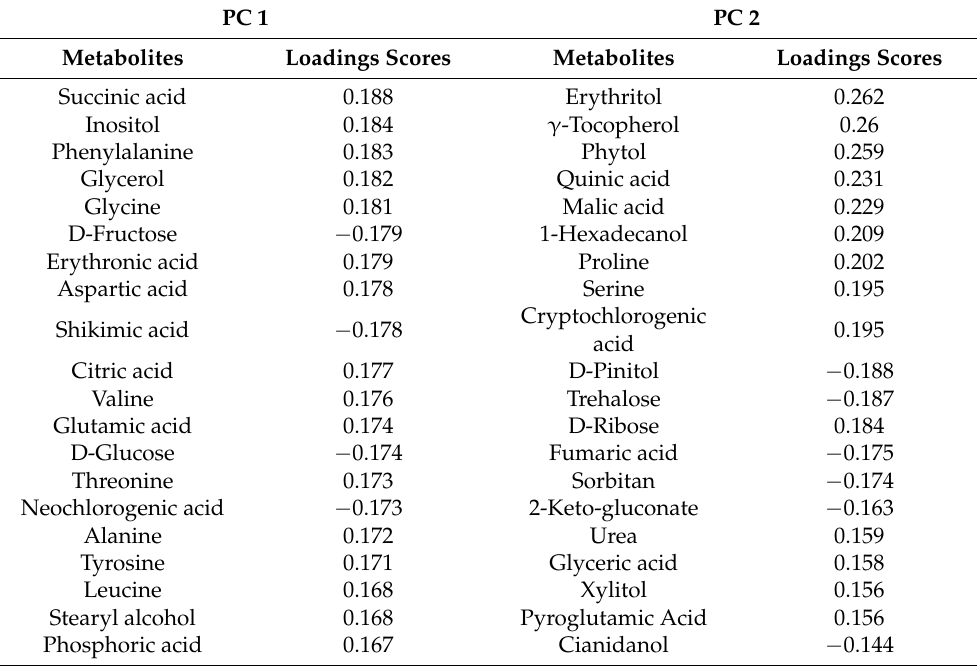
Figure 4. PCA score scatter plot of maple leaves with different colors. Each point on the PCA score scatter plot represents a sample, and each color represents a different color of maple leaves. Table 3. List of twenty metabolites with high absolute loading values on PC 1 and PC 2.